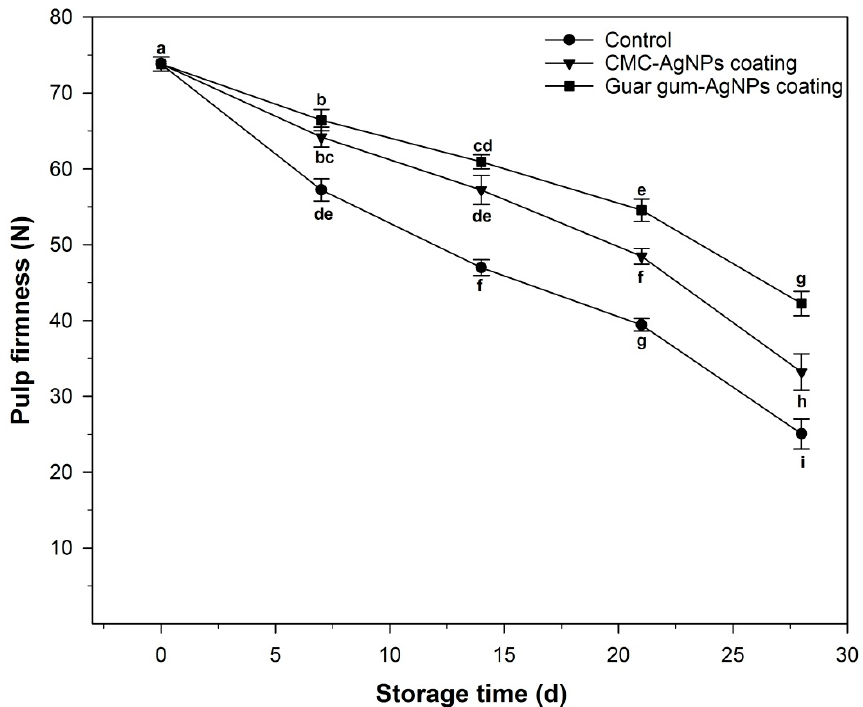
Figure 7. Effect of CMC-AgNP and guar gum-AgNP coatings on pulp firmness of “Seddik” mango fruits stored at 13 °C for 4 weeks. Vertical bars represent ± SE of means. Means with the same letter are not significantly different according to Duncan’s multiple range test ( α ≤ 0.05).